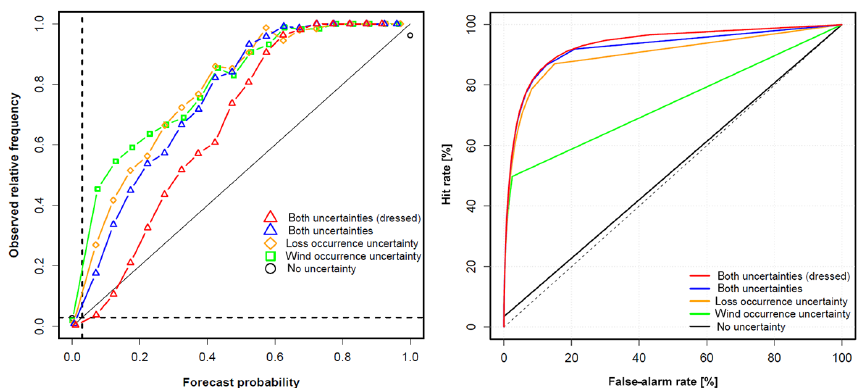
Figure 4. Reliability diagrams (left panel) and ROC curves (right panel) for the forecasts (2006–2009) with lead time 3 days for the high loss threshold (0.001‰). The climatological event frequency is indicated as a dashed horizontal/vertical black line in the reliability diagram (left panel). Forecasts considering only the meteorological (damage model) uncertainty are shown in green (yellow). Forecasts with treatment of both uncertainty sources using the undressed (dressed) ensemble are shown in blue